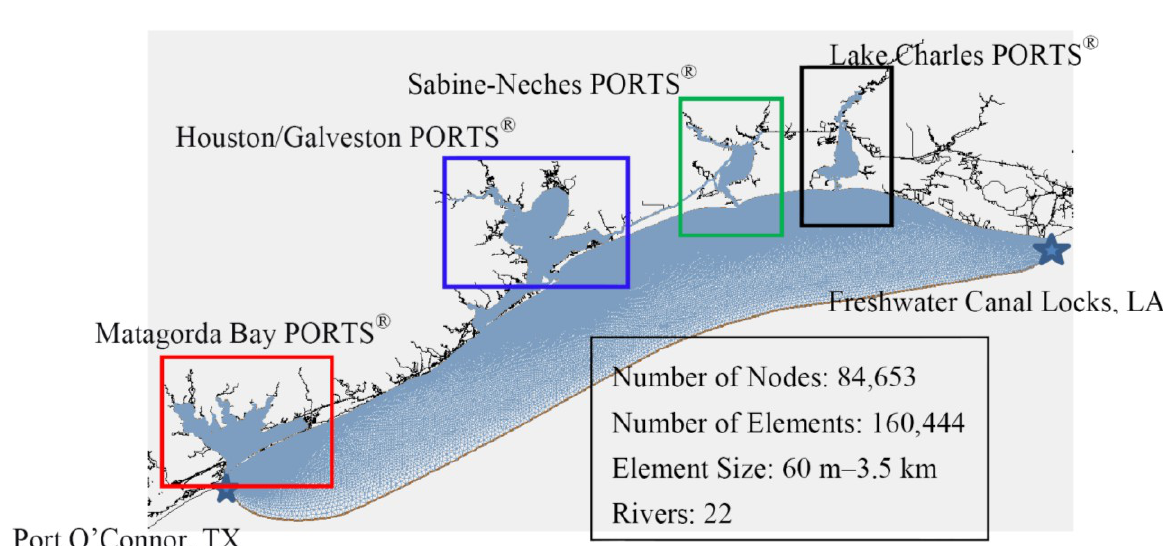
Figure 2. Northwest Gulf of Mexico Operational Forecast System (NWGOFS) model grid.